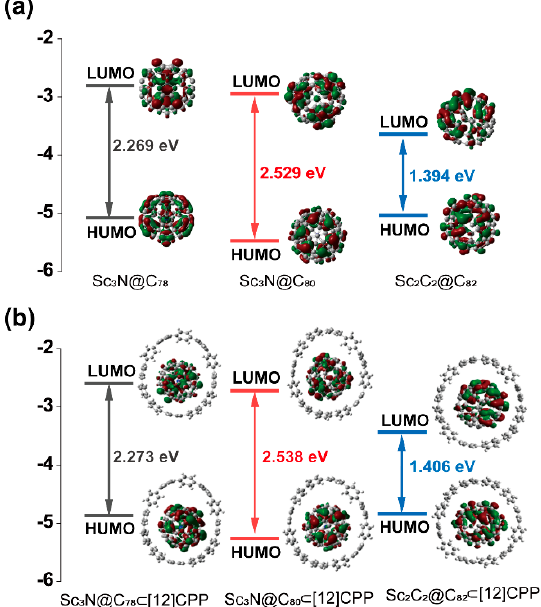
Figure 3. Molecular orbital diagrams for ( a ) Sc 3 N@C 78 , Sc 3 N@C 80 and Sc 2 C 2 @C 82 ; ( b